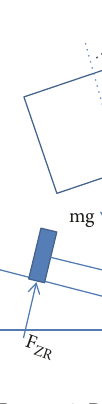
Figure 2: Bus roll